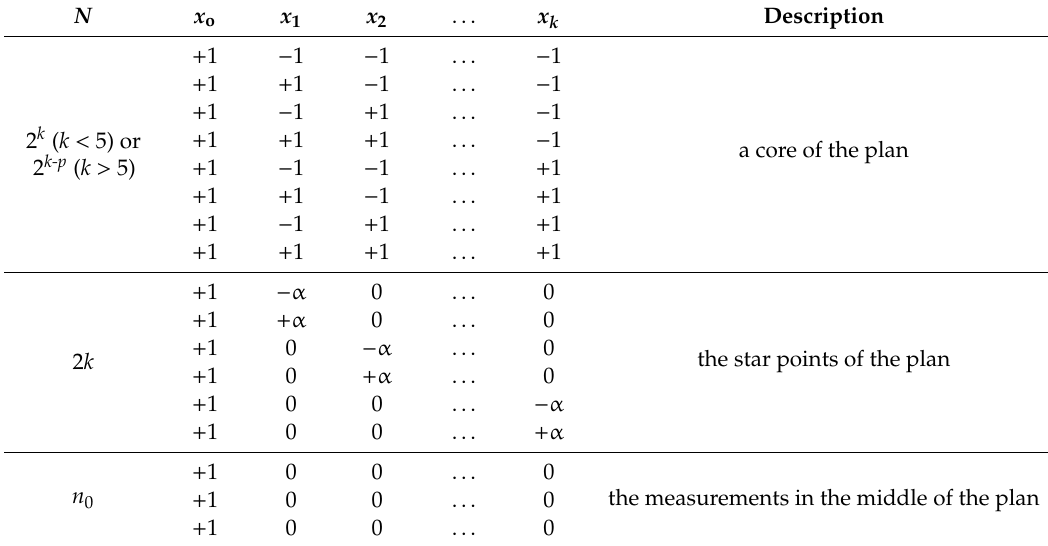
Table 4. General form of the matrix of the composition